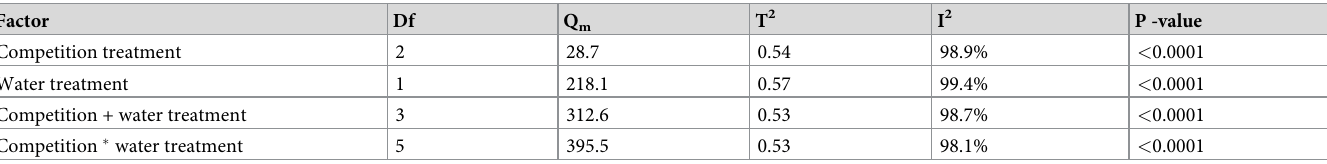
Q test statistic assess significance of between study variation [55]; T 2 measures the between study variance; and I 2 measures variance explained by heterogeneity between studies